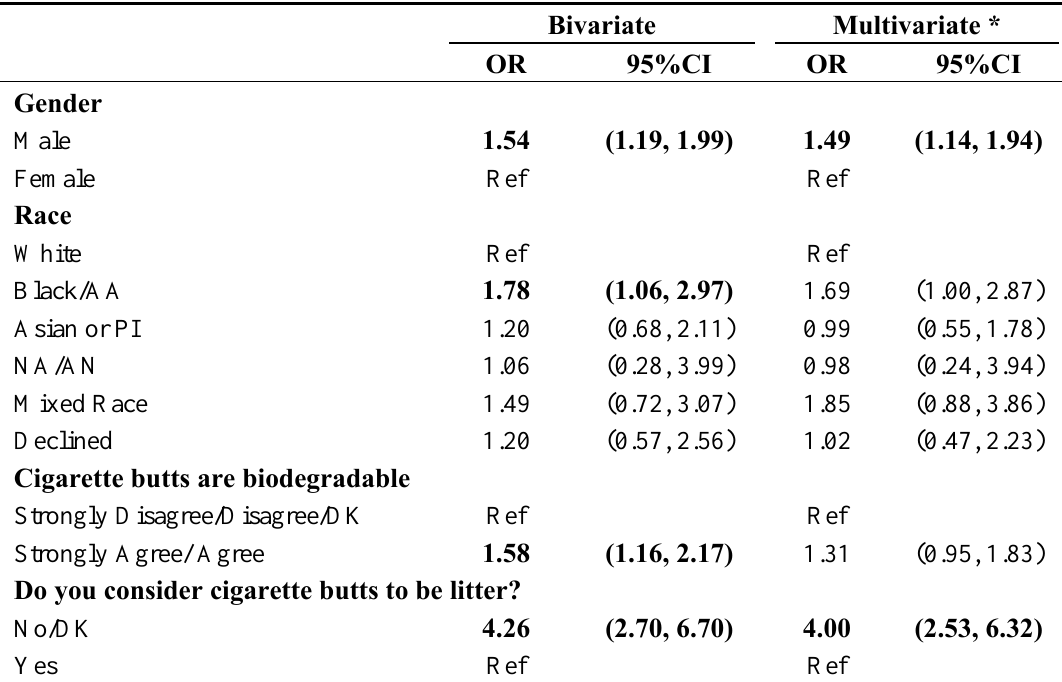
Table 5. Statistically significant predictors of past-month cigarette butt littering † among smokers (n =